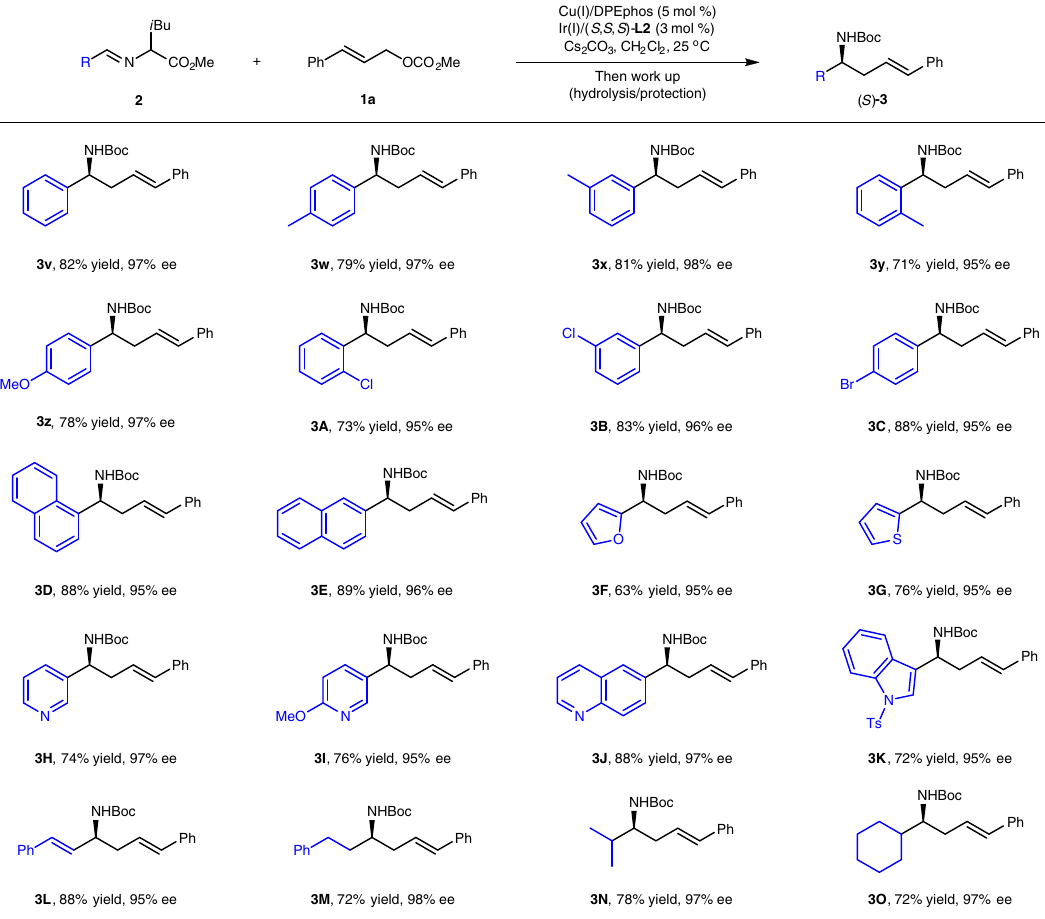
Fig. 6 Substrate Scope of aldimine esters. Reactions conditions: 1a (0.20 mmol), 2 (0.30 mmol), Cu(I)/DPEphos (0.01 mmol), Ir(I)/( S,S,S )- L2